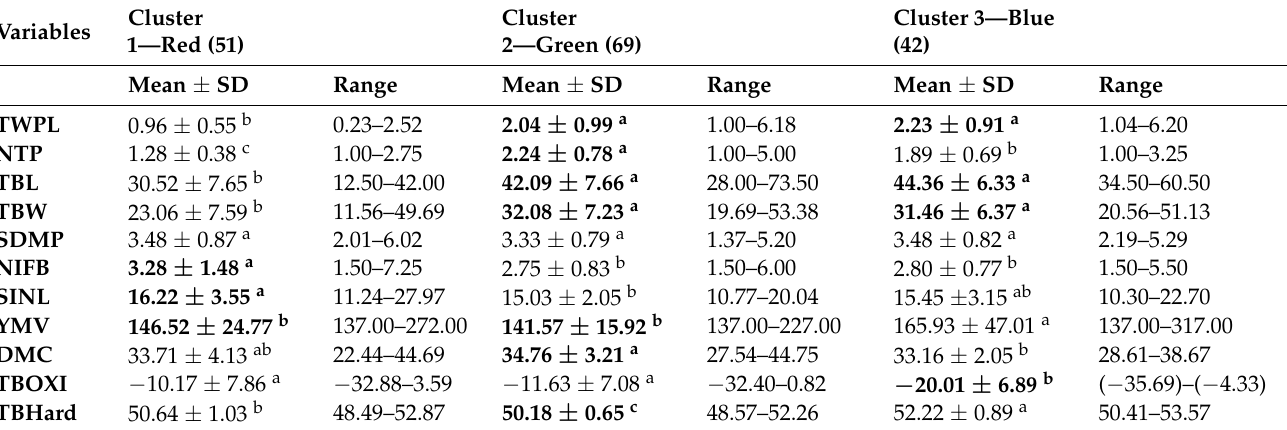
Figure 4. Clustering showing the grouping patterns of D. praehensilis accessions using 11 quantitative traits based on the Gower dissimilarity matrix. Cluster 1—Red, Cluster 2—Green, and Cluster 3—Blue. Table 3. Description of clusters for 11 quantitative traits of D. praehensilis